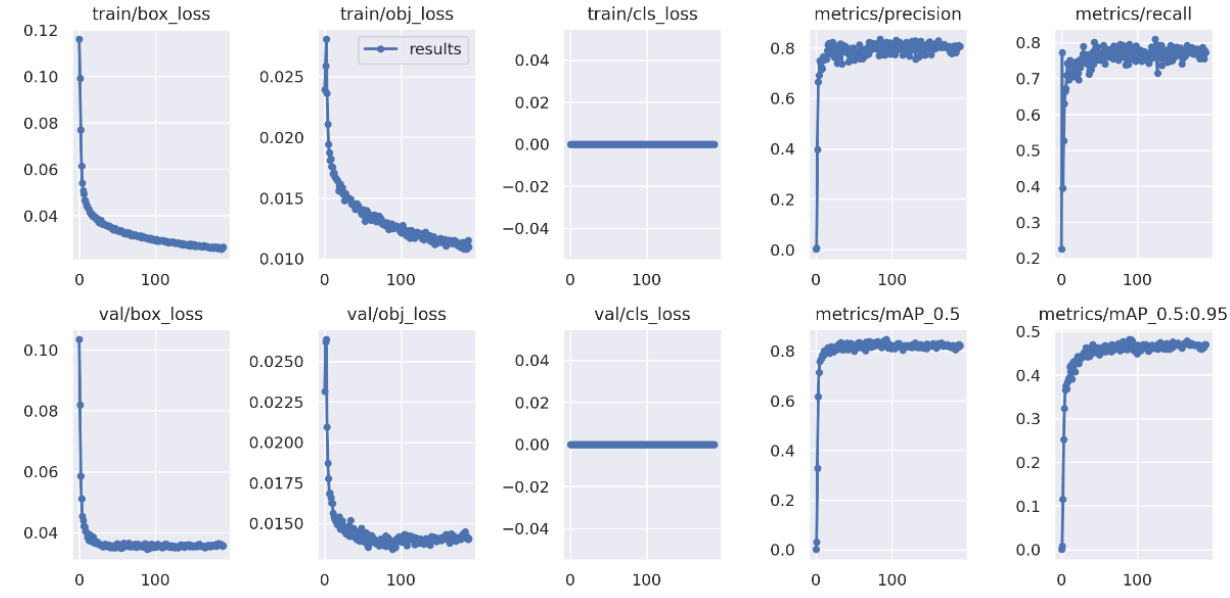
Figure 5. Training and validation results obtained from YOLOv5. Table 4. Comparison detection of mAP between CenterNet, YOLOv4, and YOLOv5 deep- learning